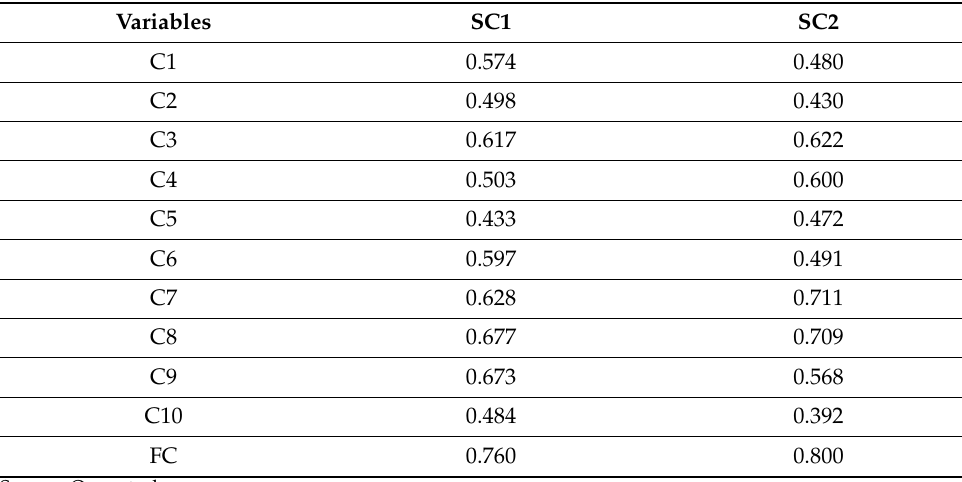
Table 7. Spearman’s correlations between the SC1 and SC2 variables and the variables concerning the functioning of the creative sector in Polish